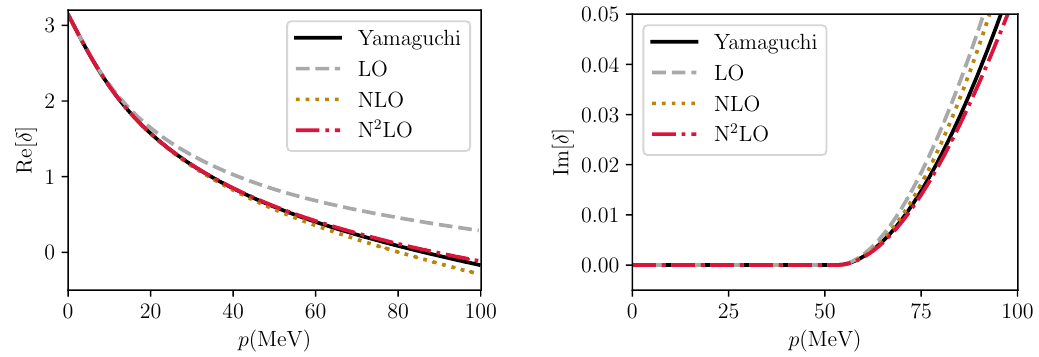
Figure 6 . Running of the couplings H 0 and H 2 in the new scheme.